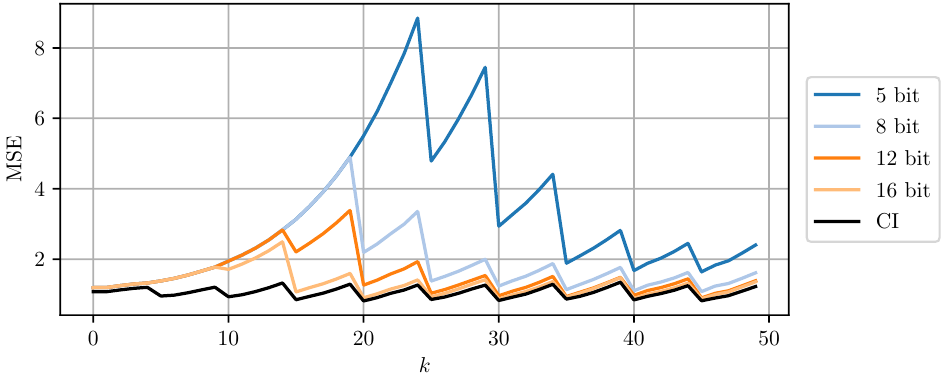
Figure 8. The estimate MSE of sensor node b plotted over time step k for varying bits per codeword using DD-CI. ‘CI’ indicates the use of a 64 bit floating point representation for each scalar.